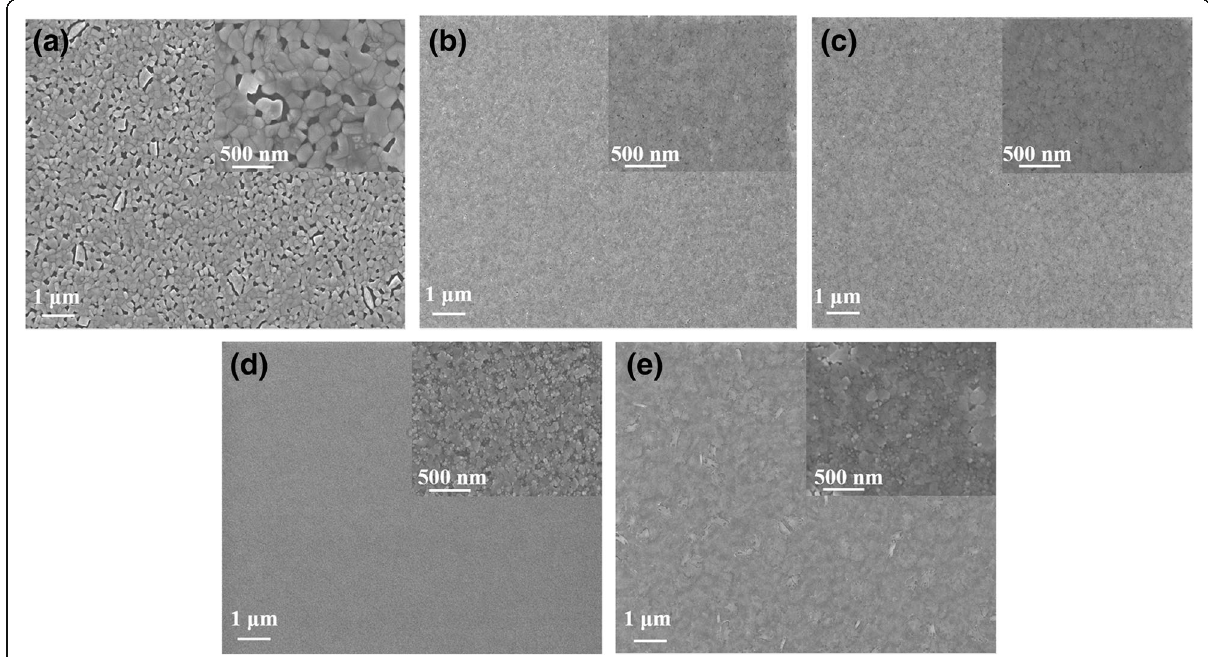
Fig. 2 SEM images of perovskite films with a 3D perovskite and quasi-2D perovskite based on PPA:Cs cations of b 2:2, c 2:3, d 2:3.5, and e 2:4; the insets show the magnified picture of corresponding SEM. b AFM topographies of corresponding perovskite